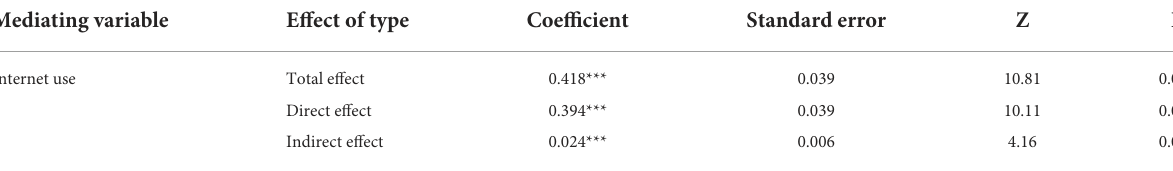
TABLE 6 Mediation test results.